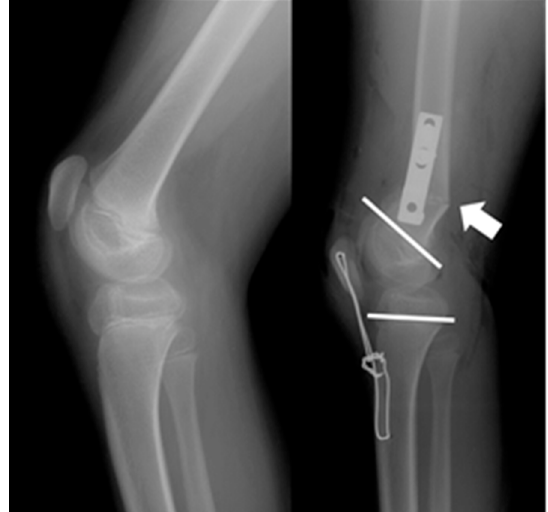
Figure 1. Preoperative and postoperative radiographs of a patient whose preoperative knee flexion contracture measured 43 ° . After resection of a wedge-shaped bone via a distal femoral extension osteotomy, significant angular deformity developed at the distal femur. Difficulty in securing fixation with a plate may be encountered and the weight-bearing surface of the distal femur may shift to the posterior condyles during the mid-stance phase of the gait.